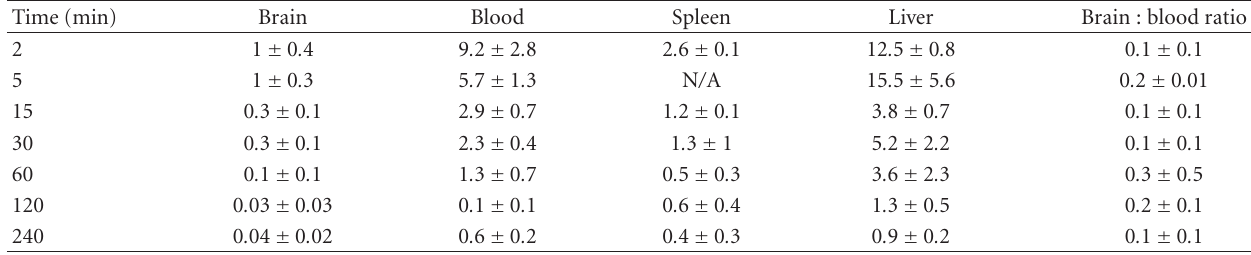
Table 1: In vivo biodistribution of 125 I-CQ by IV administration in wild type mice ( n = 105) (table represents organ uptakes in %ID/g ± SD).